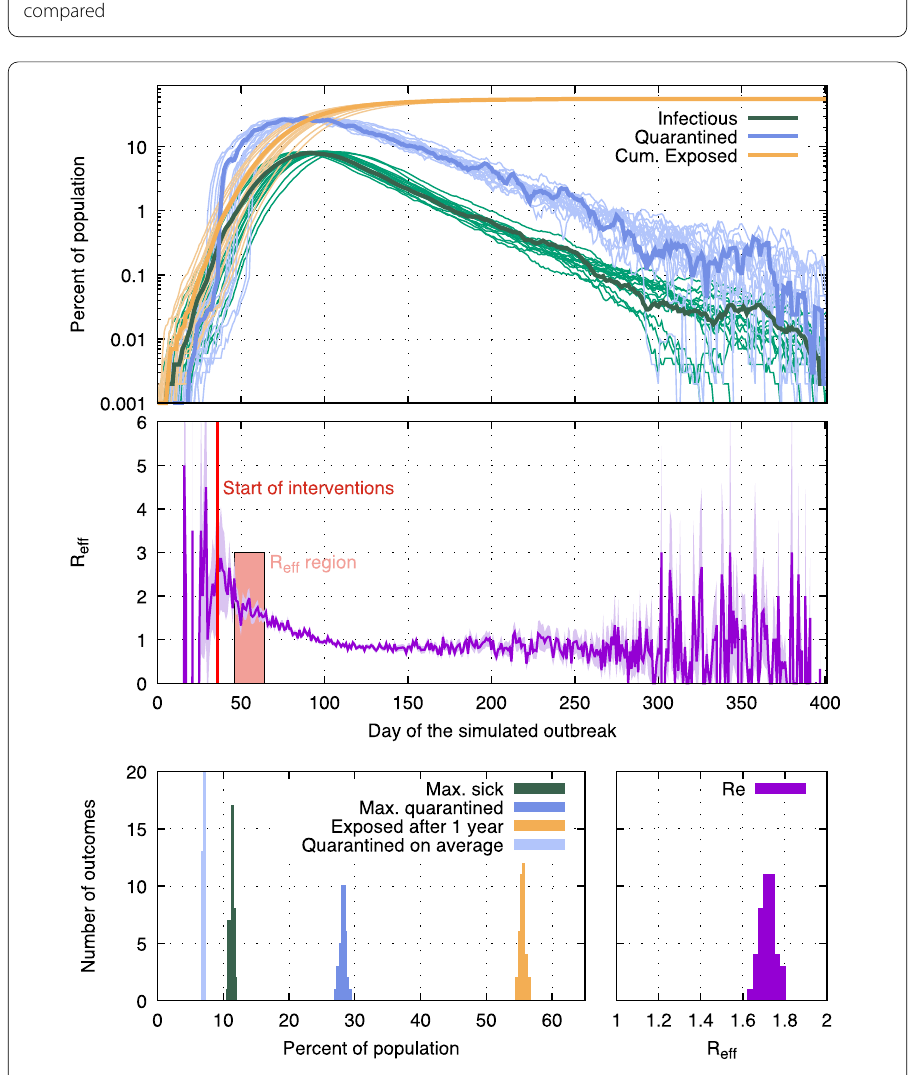
Figure 22 Same as Fig. 6 changing the following parameters: p app = 0.6, α · f m =